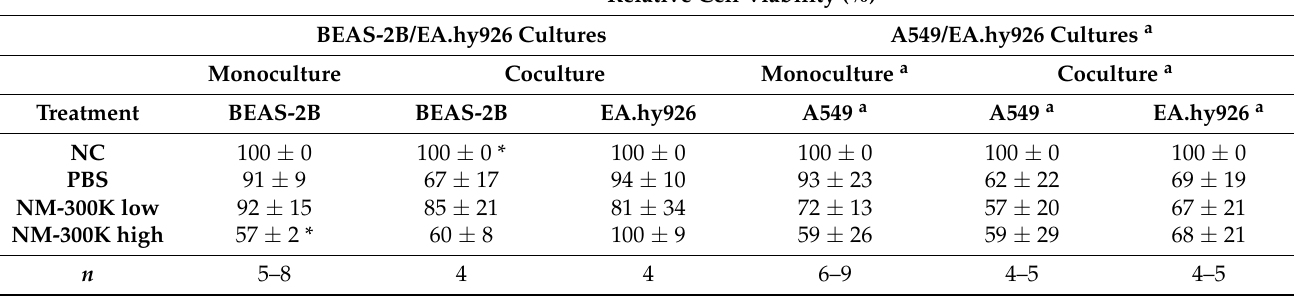
Table 4. Comparison of the relative cell viability in bronchial BEAS-2B and alveolar A549 advanced models after aerosol exposure to PBS and NM-300K. Results are presented as the mean relative cell viability (compared to NC, set to 100%) with standard deviation from 4–9 independent experiments ( n ), each with 1–2 replica culture inserts. Statistically significant differences compared to control exposed to PBS were analyzed by one-way ANOVA with Dunnett ´ s multiple comparisons post-test, and they are indicated by * p < 0.05. Data for A549 mono- and cocultures are based on our results from [39]. NC: negative control, PBS: phosphate-buffered saline, NM-300K low: nominal 1 µ g/cm 2 , NM-300K high: nominal 10 µ g/cm 2 . Relative Cell Viability (%) BEAS-2B/EA.hy926